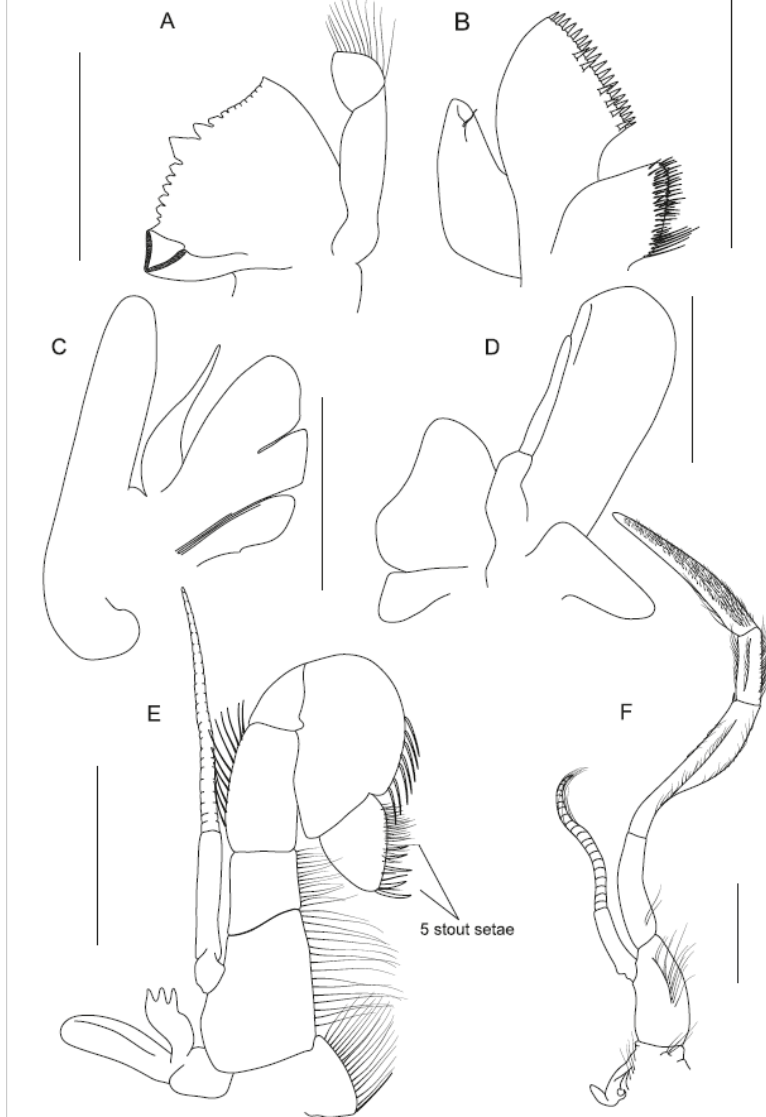
Figure 4. Mouthparts of Sclerodora crosnieri sp. nov., holotype, right parts: ( A )—mandible. ( B )—first maxilla, inner view. ( C )—second maxilla, setae removed. ( D )—first maxilliped, setae removed. ( E )—second maxilliped. ( F )—third maxilliped. All scales: 3 mm.